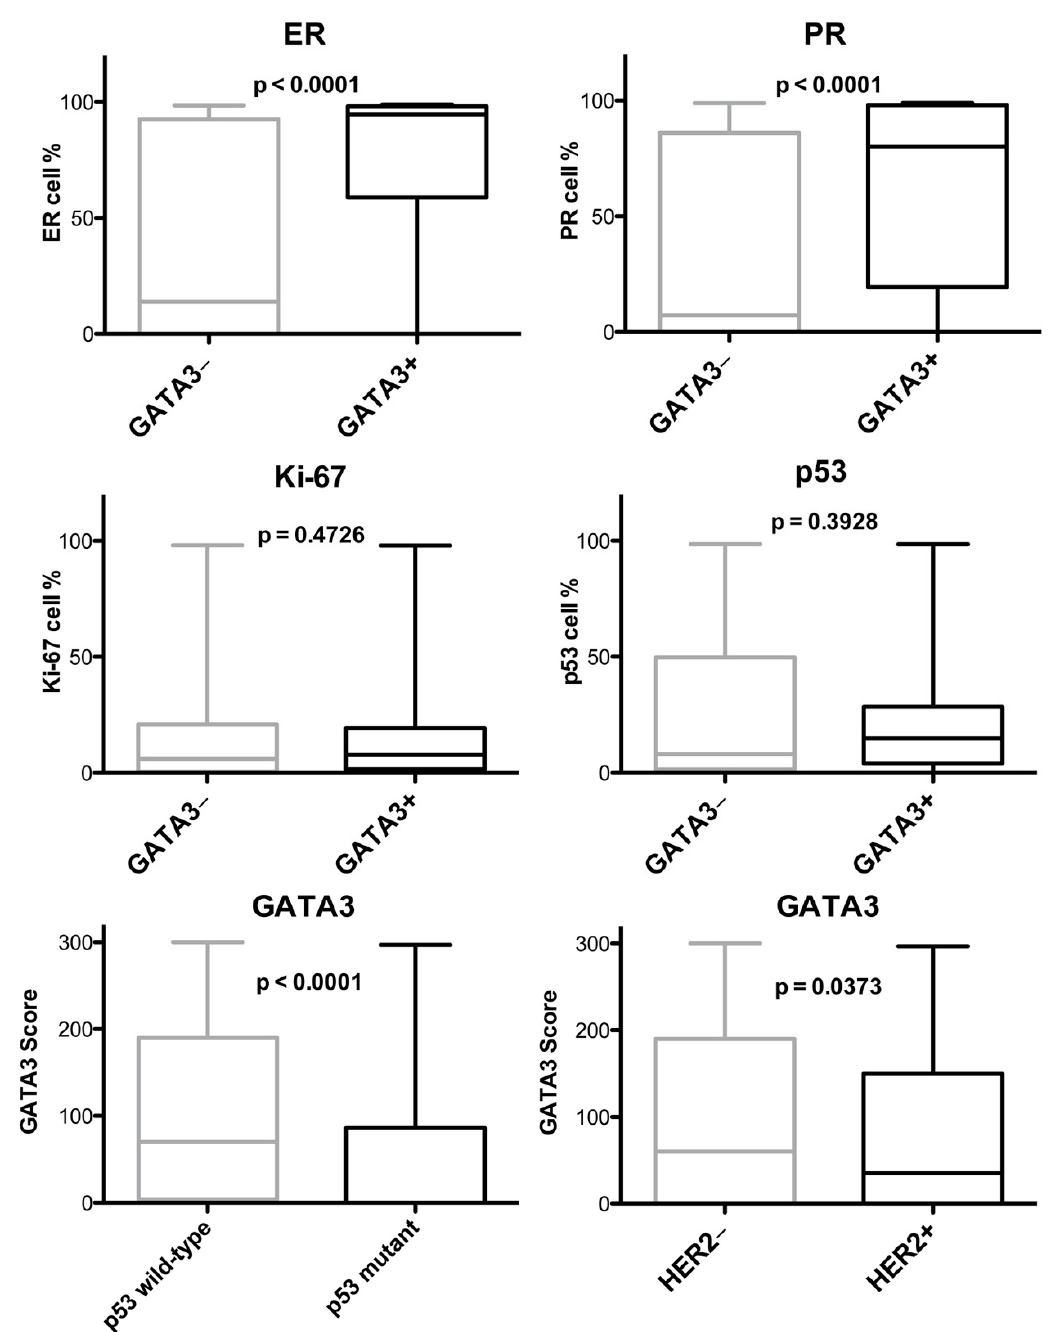
Figure 2. Box-plot charts showing the correlation between GATA3 expression (i.e., − is < 1%; + is ≥ 1%) and the biological factors ER, PR, proliferative index Ki-67, and p53, and the box plot chart of the GATA3 histological score according to p53 immunohistochemical pattern and HER2 status; p -values from the two-sided t -test comparisons are reported.